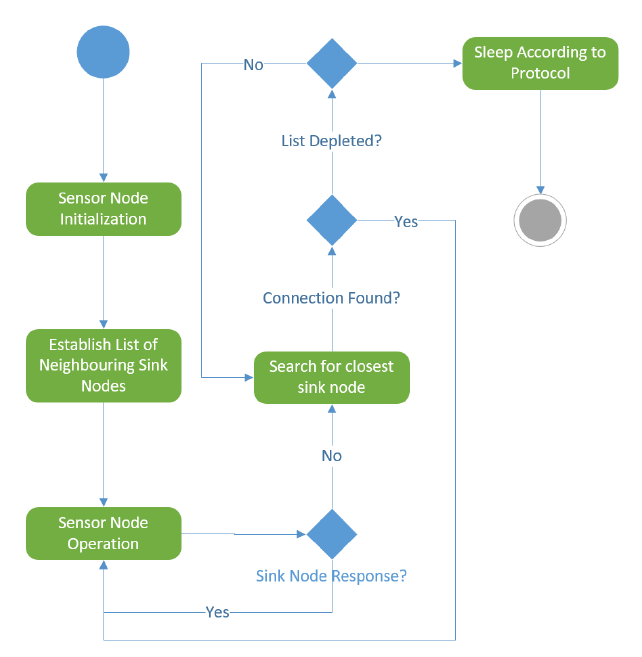
Figure 4. Sensor node setup and reconfiguration process.